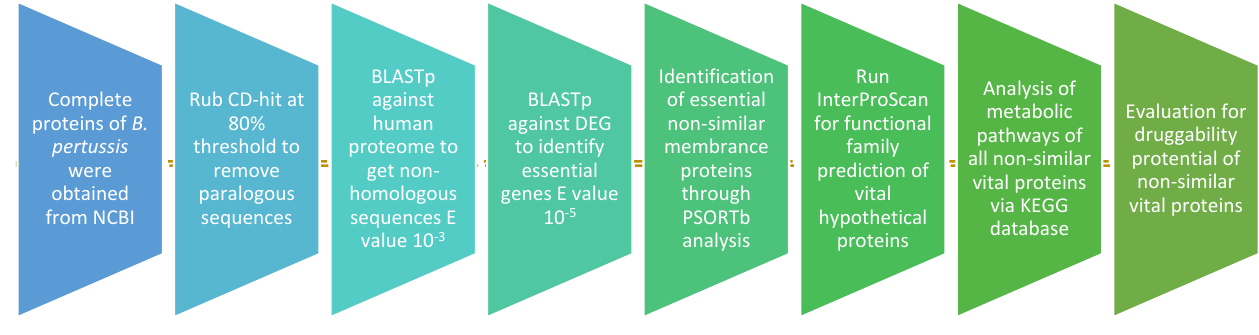
Figure 1. Flow chart of the study design.